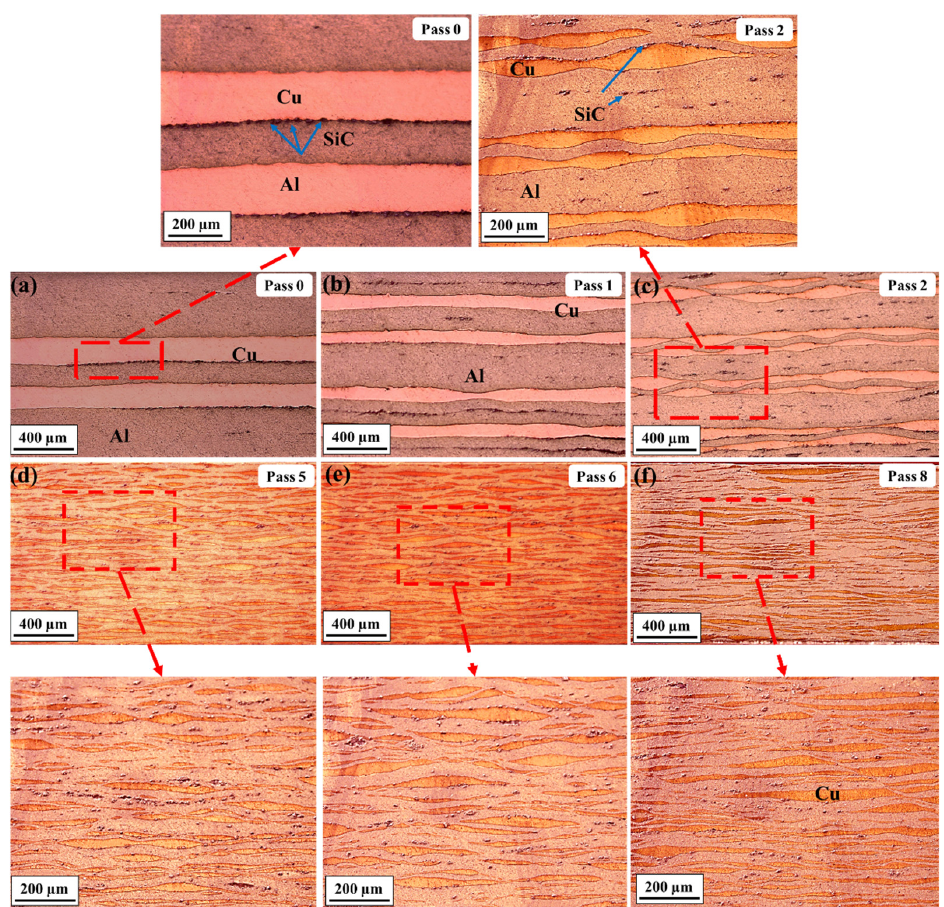
Figure 5. SiC particle distribution at different passes of the CARBed Al/Cu/2wt%SiC composite.